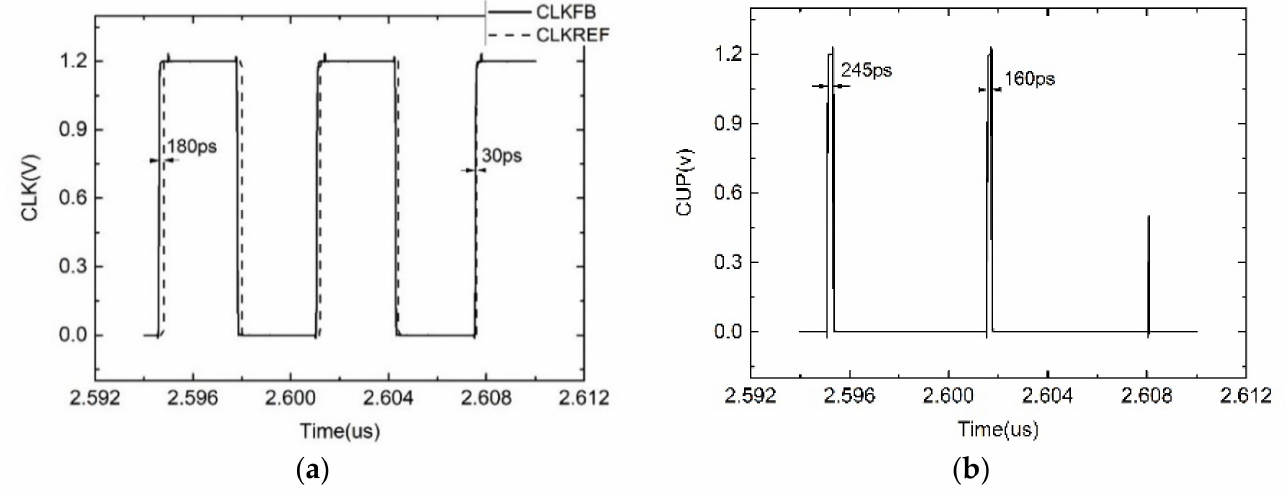
Figure 10. Simulation results ( a ) the PWC control pulse of SAR; ( b ) the phase error between CLKFB and CLKREF.